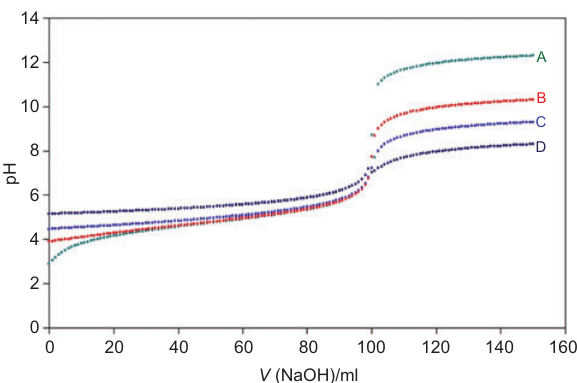
Figure 2 Curve for the titration of acetic acid with sodium hydrox- ide. Curve A: 0.1 M acid with 0.1 M base. Curve B: 1 × 10 -3 M acid with 1 × 10 -3 M base. Curve C: 1 × 10 -4 M acid with 1 × 10 -4 M base. Curve D: 1 × 10 -5 M acid with 1 × 10 -5 M